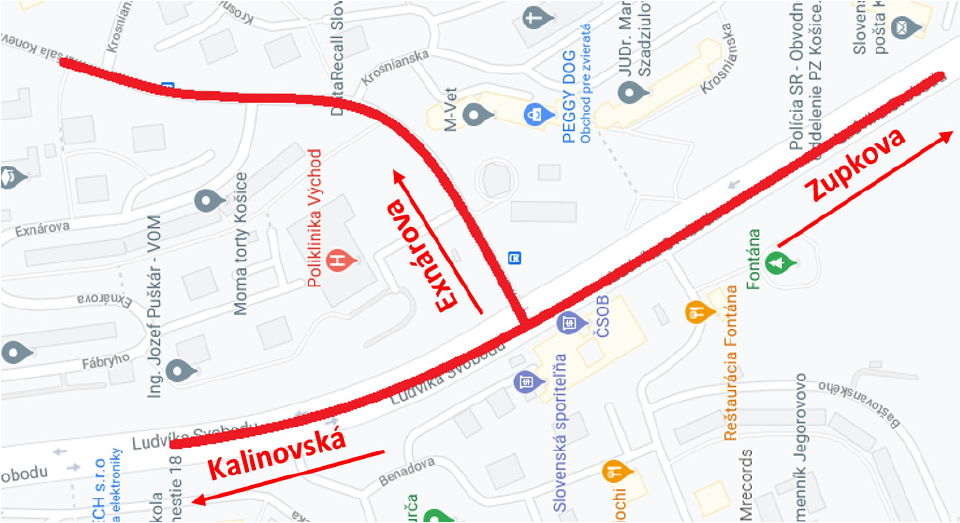
Figure 3. Intersection of Ludvík Svoboda Street and Maršal Konev